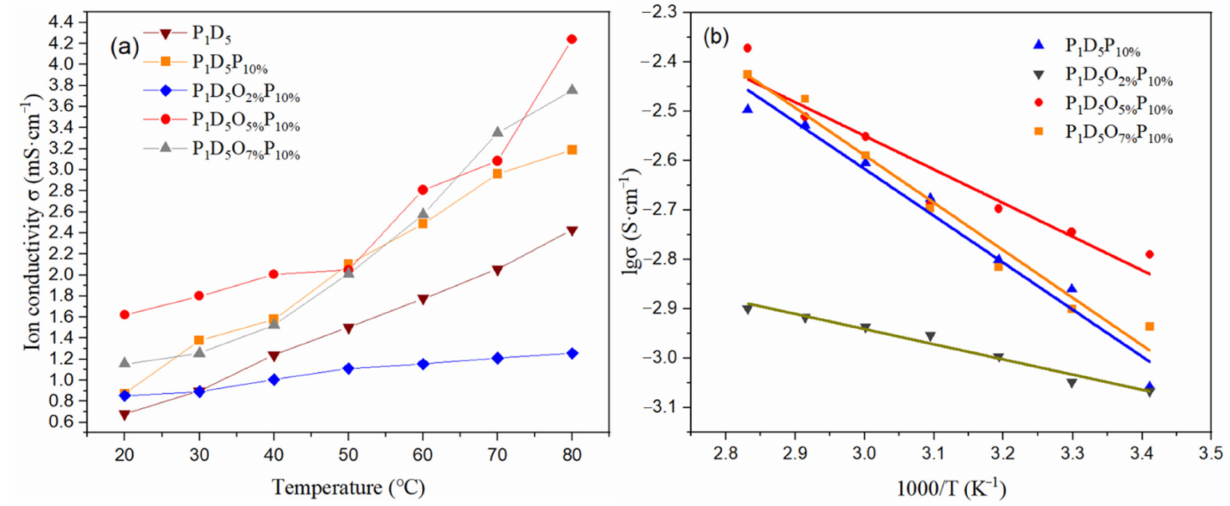
Figure 8. ( a ) Ionic conductivity diagram and ( b ) Arrhenius conductivity diagram of membranes prepared with different OVAPOSS contents at different temperatures.